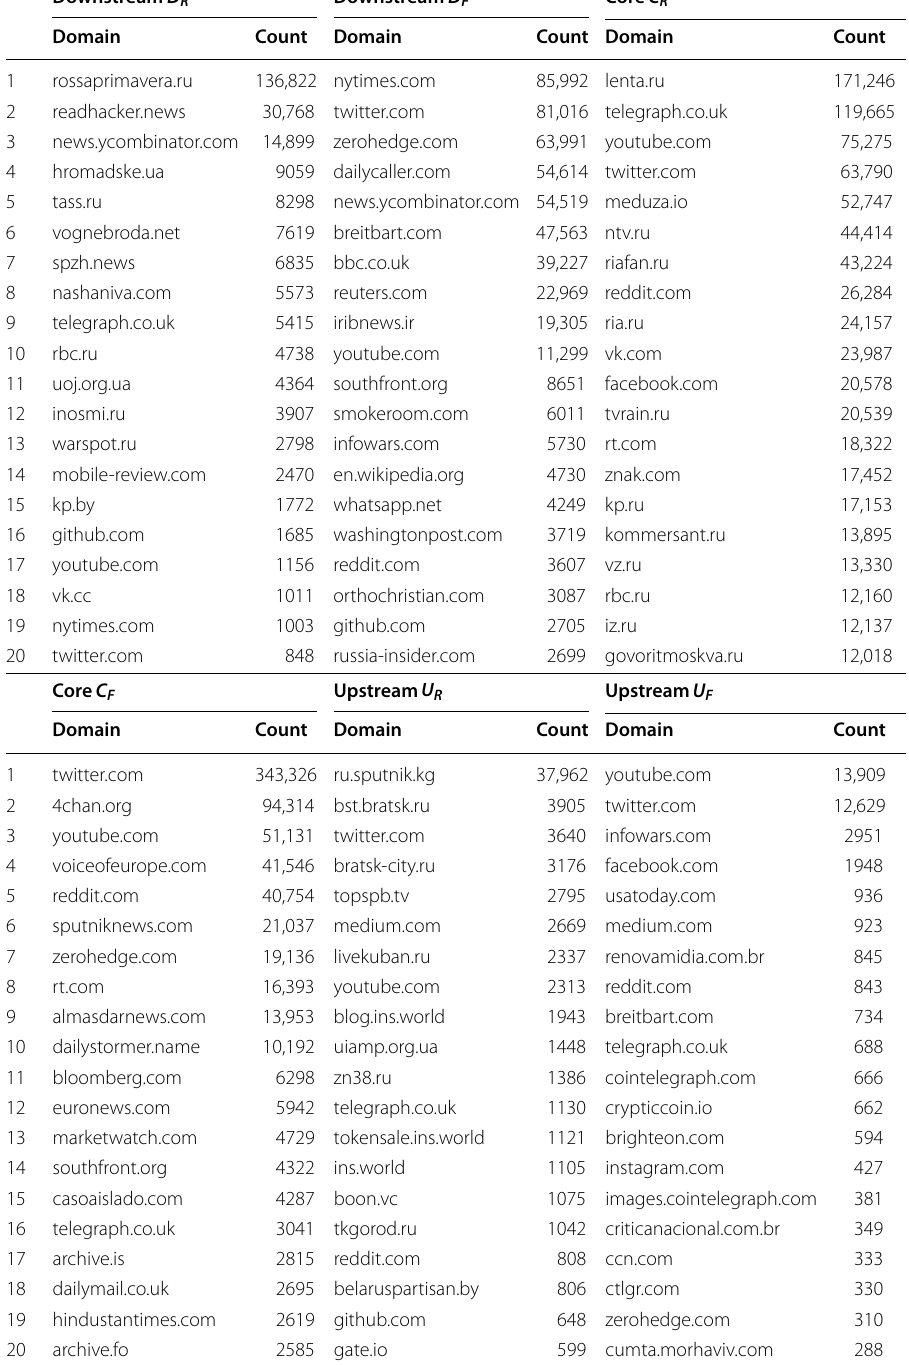
Table 6 Top URL domains shared in the main communities of the network G 1 (Sep. 2015 to June 2019, Fig.